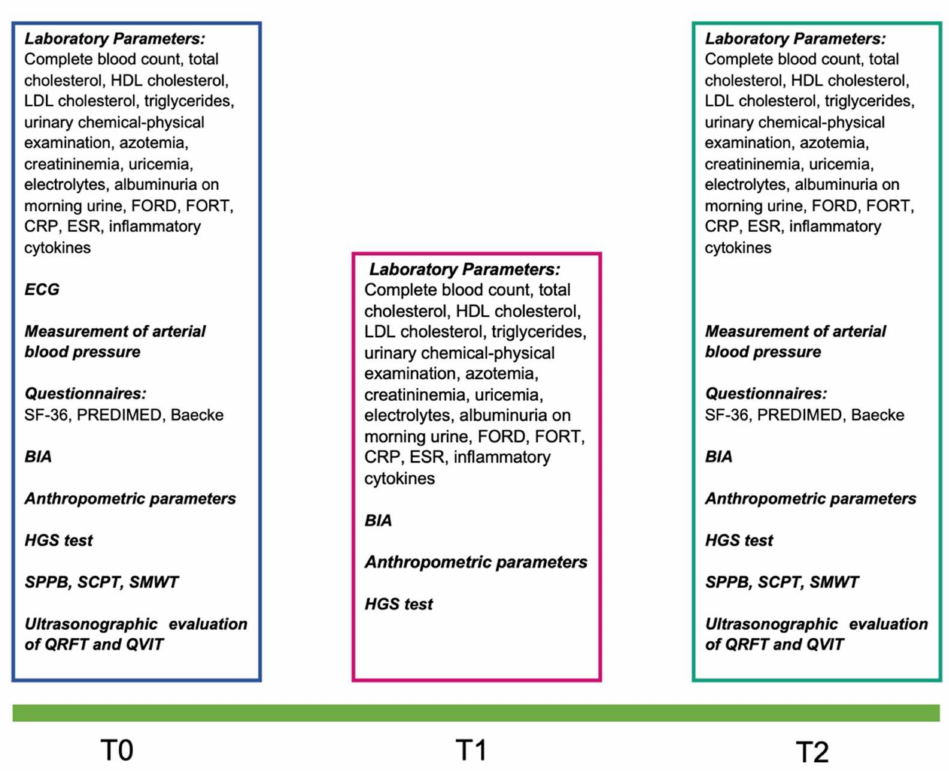
Figure 1. Laboratory parameters, tests, and questionnaires performed at the various times of the study. Abbreviations: BIA, bioelectrical impedance analysis; CRP, C-reactive protein; ECG, electrocar- diogram; ESR, erythrocyte sedimentation rate; FORD, free oxygen radical defense; FORT, free oxygen radicals test; HDL, high-density lipoproteins; HGS-test, handgrip strength-test; LDL, low-density lipoproteins; PREDIMED, prevenci ó n con dieta Mediterr á nea; QRFT, quadriceps rectus femoris thickness; QRFT, quadriceps vastus intermedius thickness; SF-36, short form-36; SCPT, stair climb power test; SMWT, six-minutes walking test; SPPB, short physical performance